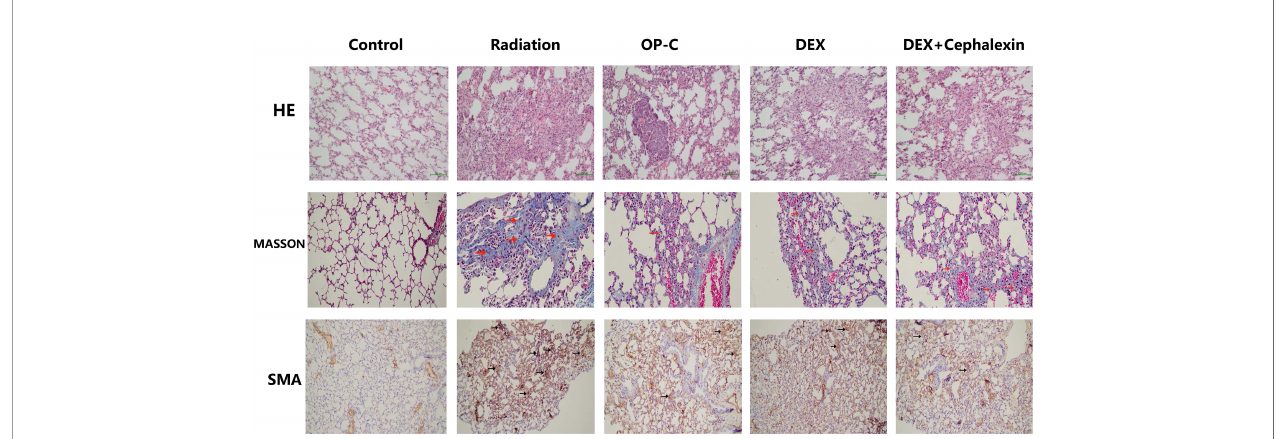
FIGURE 1 | Effects of Ophiopogonin C (OP-C) on the histological changes, including pulmonary in fl ammation and fi brosis, in the lung tissue at 28 weeks after whole thoracic irradiation. Photomicrographs show staining of mouse lung tissue sections with hematoxylin and eosin staining, Masson staining, and SMA detected by immunohistochemical staining in mice from the blank control, radiation-only, OP-C, dexamethasone (DEX), and DEX + cephalexin